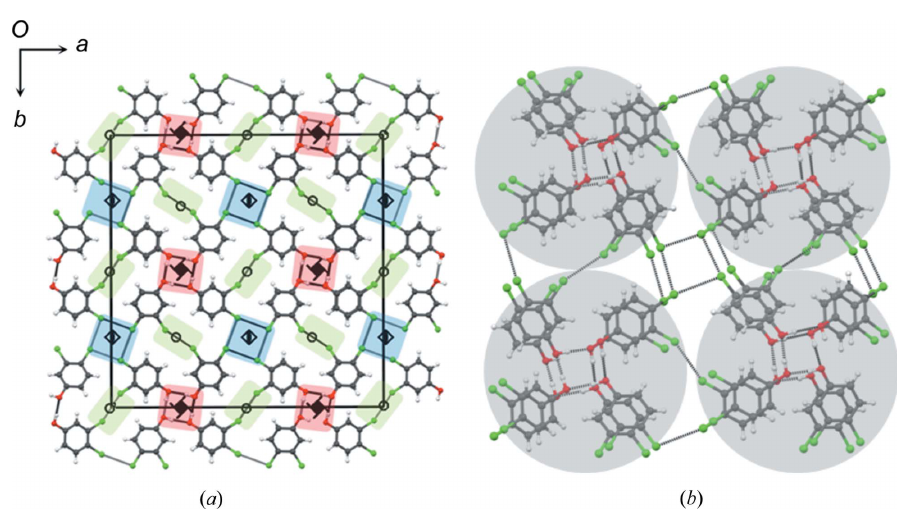
Figure 1 ( a ) Crystal structure of 3,4-dichlorophenol: hydrogen bond (red), type I contacts (green) and type II contacts (blue) showing the symmetry requirement for different non-covalent interactions. ( b ) The halogen bond acts as interlayer glue pulling two layers together.